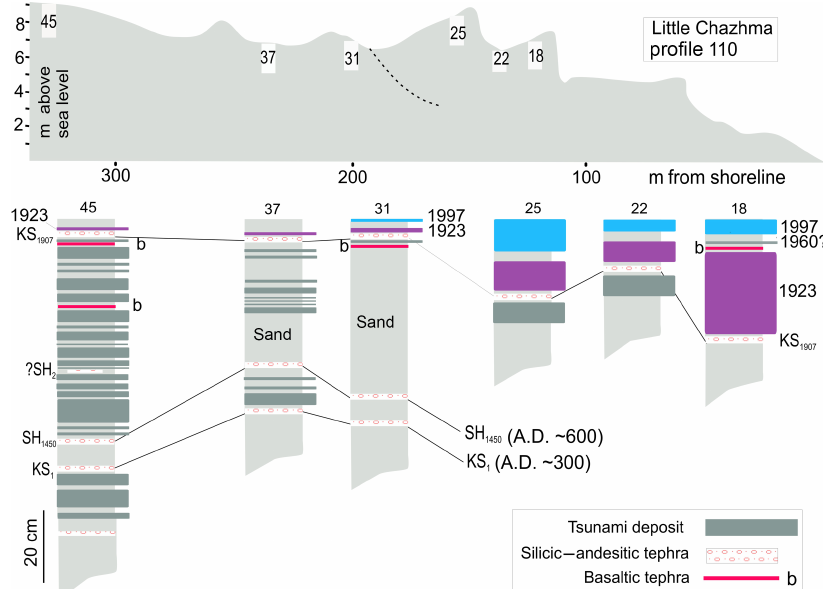
Figure 8. Profile 110, Chazhma area (Fig. 1 location; more extensive key in Fig. 4). This profile has been uplifted through time – the landward part of the profile is higher. Excavation 45 contains many tsunami sand layers currently at high elevation, which when reconstructed were lower (Fig. S5). In excavations 37 and 31, some of the section was too sandy (not enough soil development) to distinguish individual sand layers. The profile shows the distribution of 20th century deposits, as well as a tsunami deposit very close below KS 1907 . The 1923 tsunami(s) reached the highest point shown on this profile, whereas 1997 and “below KS 1907 ” were smaller. The deposit we tentatively assigned to Chile 1960 on this profile is not included in Table 3 because the deposit was not well preserved; it is higher than any other excavation containing a deposit we attribute to Chile